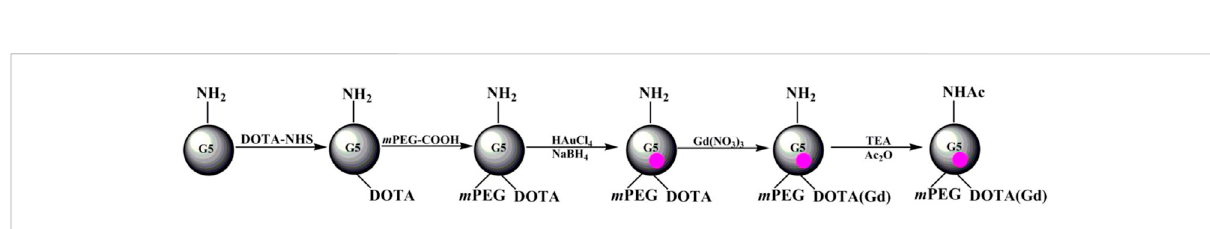
FIGURE 2 Schematic illustration of the preparation of (Au 0 ) n -G5.NHAc- m PEG-DOTA 30 (Gd). TEA and Ac 2 O represent triethylamine and acetic anhydride,